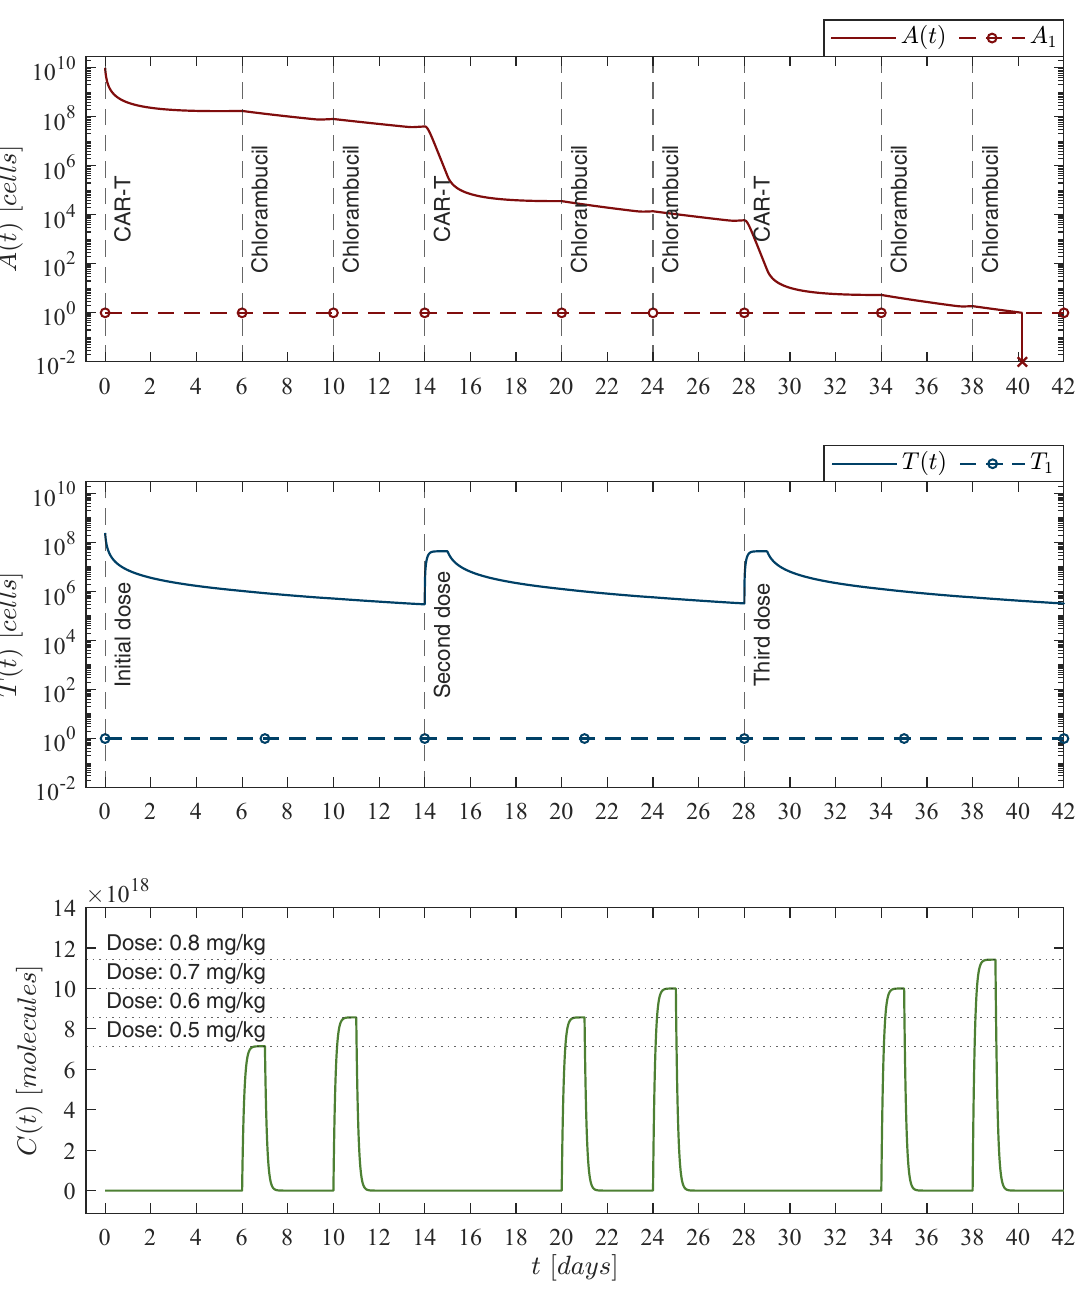
Figure 8. Increasing chemoimmunotherapy case. The in silico experimentation allowed us to determine the increments of the chlorambucil dosing to achieve leukemia cells eradication as follows: 40 mg at day 6, 48 mg at days 10 and 20, 56 mg at days 24 and 34, and 64 mg at day 38 as illustrated in the lower panel. The immunotherapy infusions remain as 245,633,284 CAR-T cells at days 0, 14, and 28 as shown in the middle panel. The combined therapy strategy is illustrated in the upper panel with the leukemia cells evolution [ A ( t )] which go below the threshold of complete eradication by day 41 [ t = 40.18 ] for an initial non-solid tumor population of 10 10 cancer cells. Total doses of the chemoimmunotherapy treatment are as follows: 336 mg of chlorambucil, and 736,899,852 CAR- T cells. It should be noted that the final CAR-T cells count is lower than the weekly and fortnight CAR-T cells cases of Figures 5 and 6, respectively. For this case, parameter values are set as follows: ρ A = 0.1680, ρ T = 2.9409 × 10 − 13 , µ T = 1/14, and α T = 1.2560 × 10 − 7 by Equation (12). For the values of µ AC and µ TC see columns ‘Cytotoxicity µ AC ( κ ) ’ and ‘Cytotoxicity µ TC ’ of Table